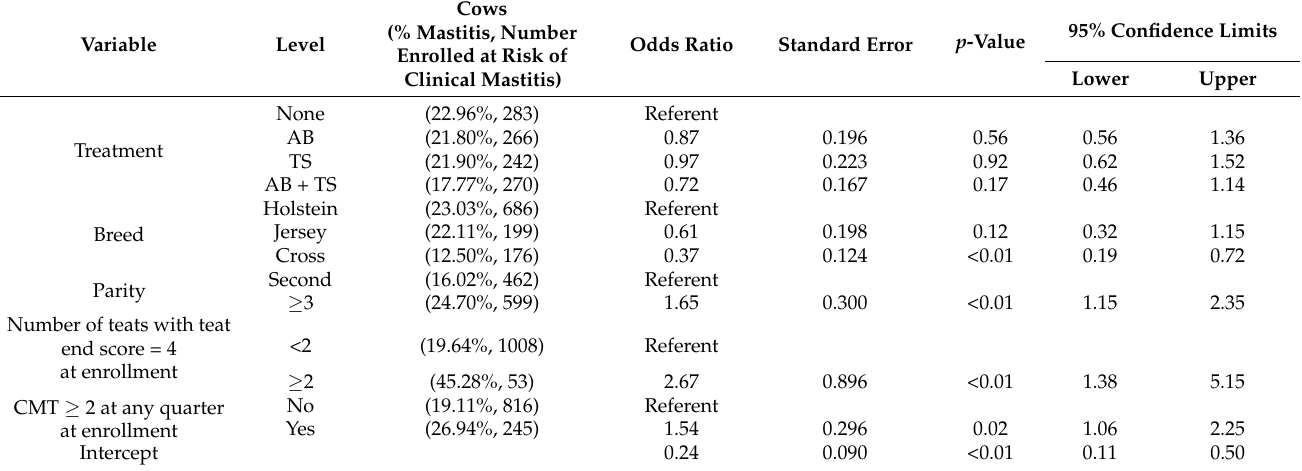
Table 3. Generalized linear mixed model with logit link predicting clinical mastitis from calving to ≤ 150 days in milk among different treatment groups (AB, TS, AB + TS, None) 1 on California dairies ( n = 8